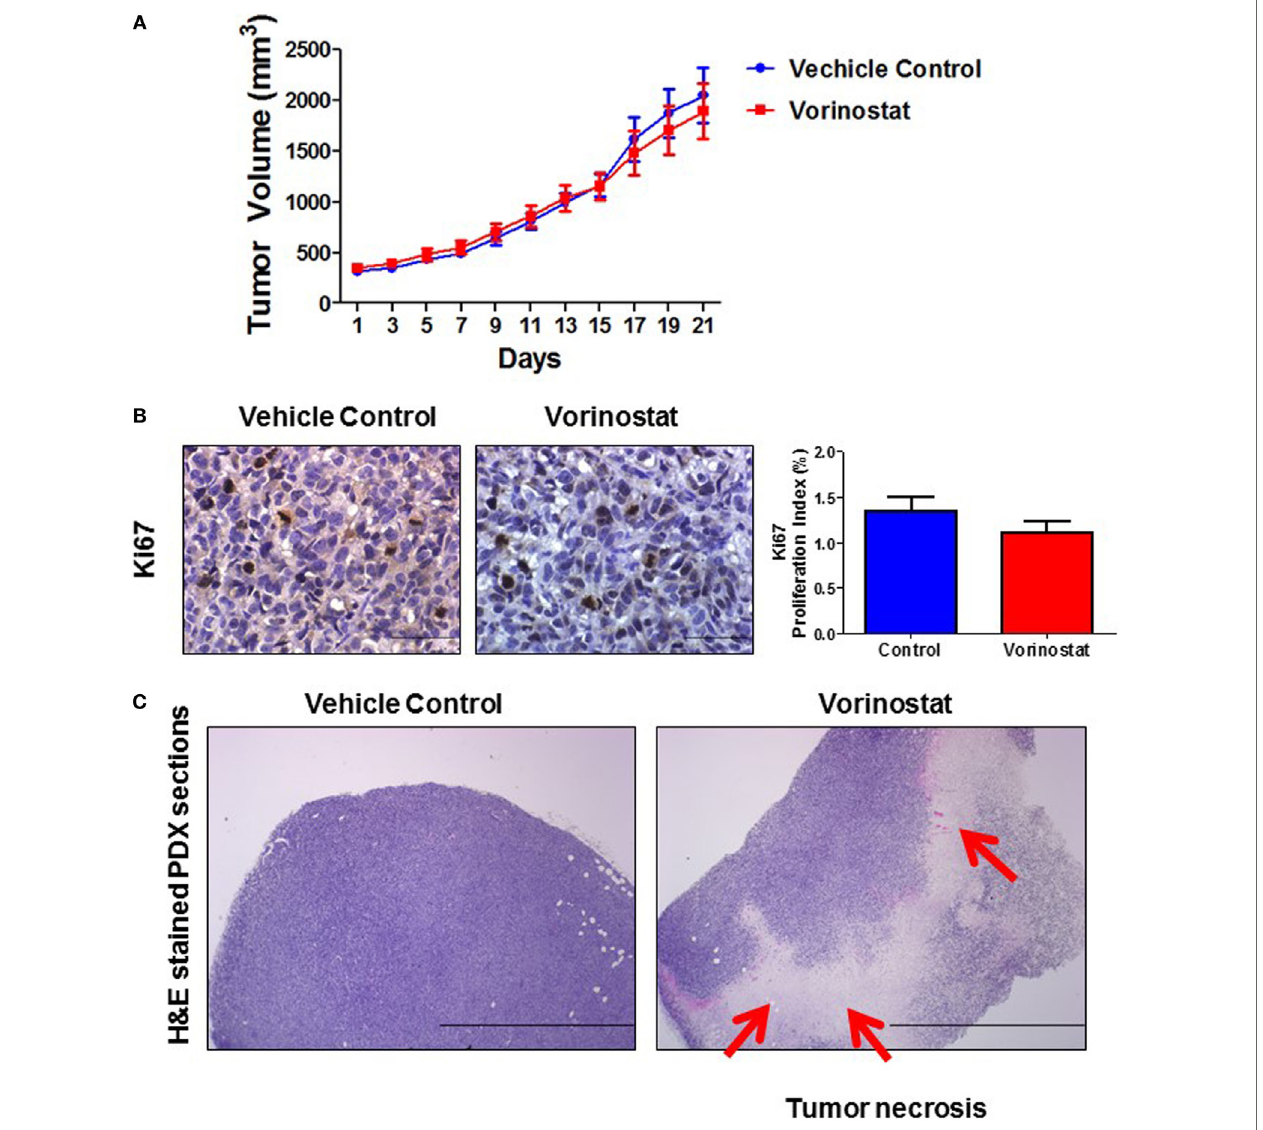
FIGURe 2 | Monotherapy of vorinostat which did not suppress tumor growth in a patient-derived xenograft model (COA/UAB-15), but did induce tumor necrosis. (a) When tumor volumes reached ~300 mm 3 , 50 mg/kg vorinostat or vehicle was administered once a day to tumor-bearing mice ( N = 10/group) for 21 days. (b) Immunohistological analysis for the proliferation marker Ki67 showed no difference in growth fraction between vorinostat- and vehicle-treated mice group. (C) H&E staining of formalin-fixed paraffin-embedded tissue prepared from tumor harvested from vehicle-treated or vorinostat-treated mice 24 h after the last day of treatment. Red arrows indicate examples of necrotic